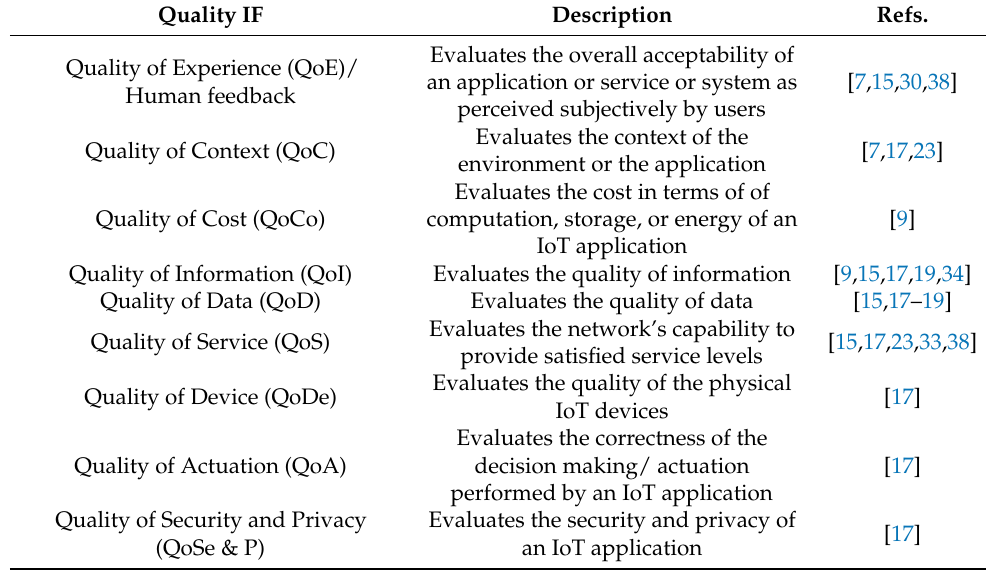
Table 5. Quality IFs for IoT.